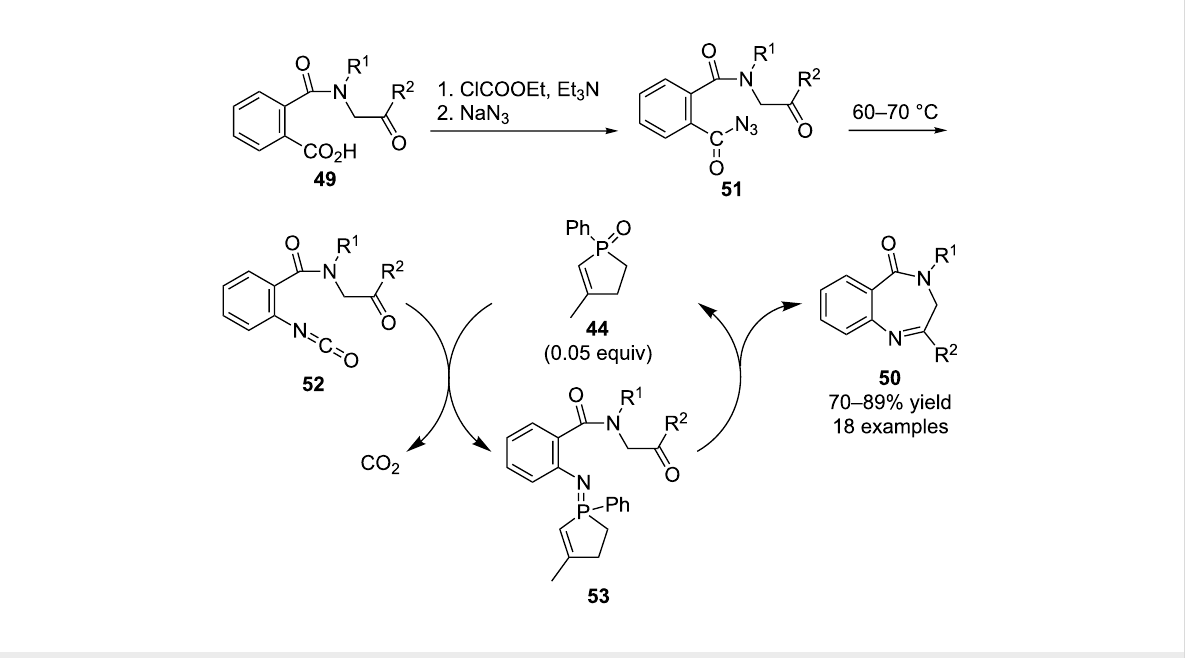
Scheme 15: Catalytic aza-Wittig reactions in 1,4-benzodiazepin-5-one